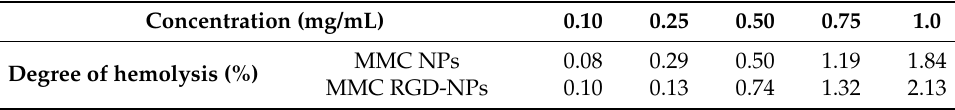
13 of 22 Figure 7. Prediction and analysis of the MMC-loading mechanism of nanoparticles. ( A ) The struc- ture of MMC. ( B ) Fmoc-Lys-PEG was the ligand and MMC was the receptor. ( C ) Fmoc-Lys-PEG was the ligand and MMC was the receptor (Fmoc limited binding pocket). ( D ) MMC was the ligand